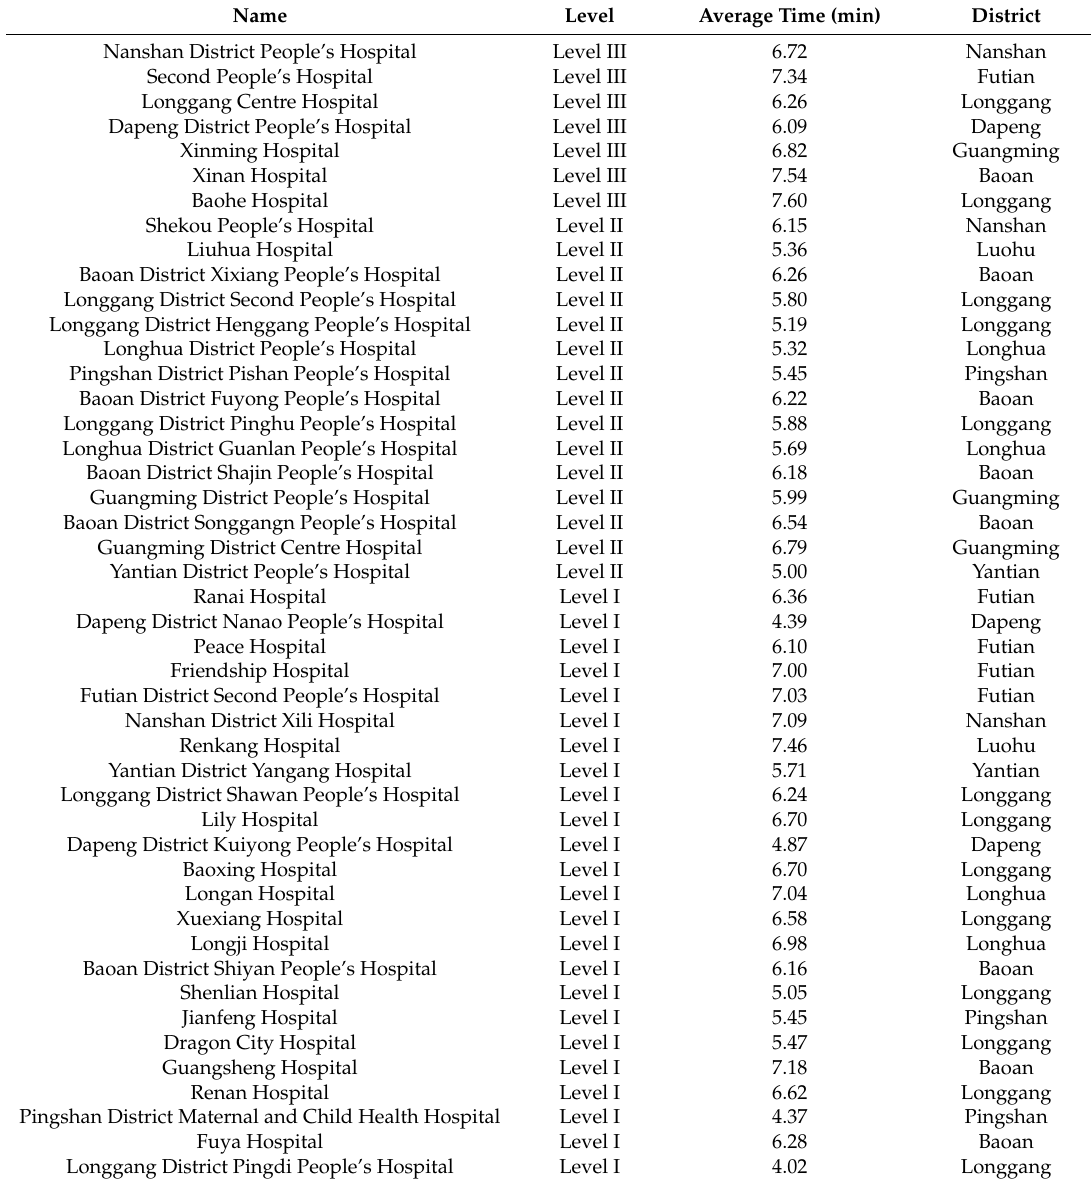
Table 4. Information about low-level trauma